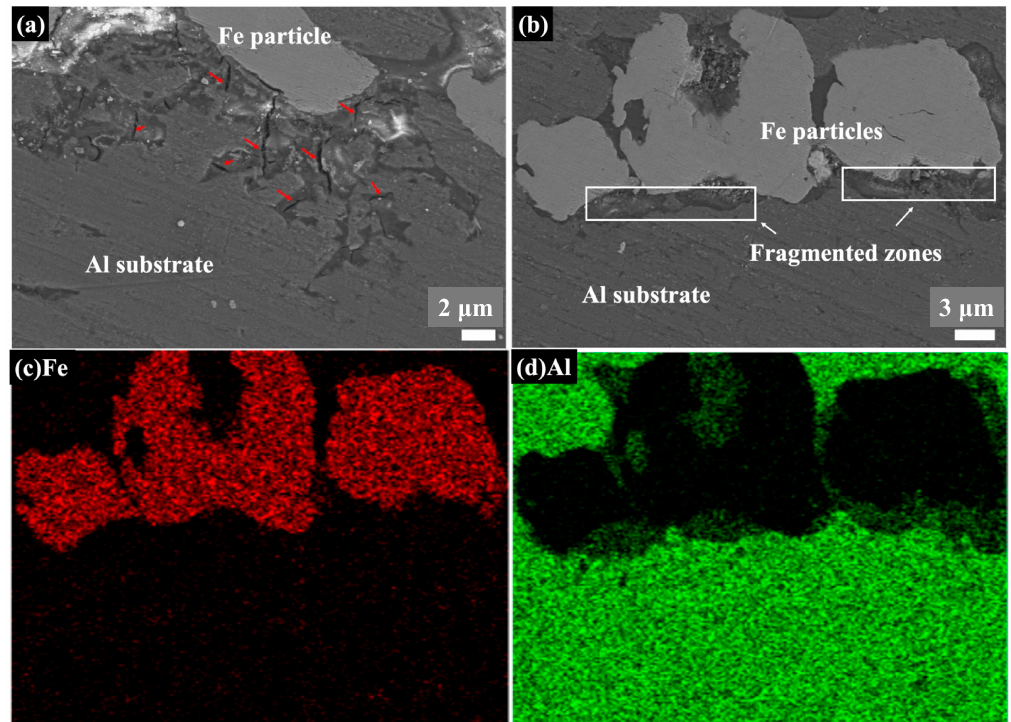
Figure 9. SEM images and EDS elemental mapping along the coating/substrate interface of Fe-25Al- Al; microcracks originated and expanded in the fragmented zones in ( a ) whereas non-continuous fragmented zones formed along the interface in ( b – d ).